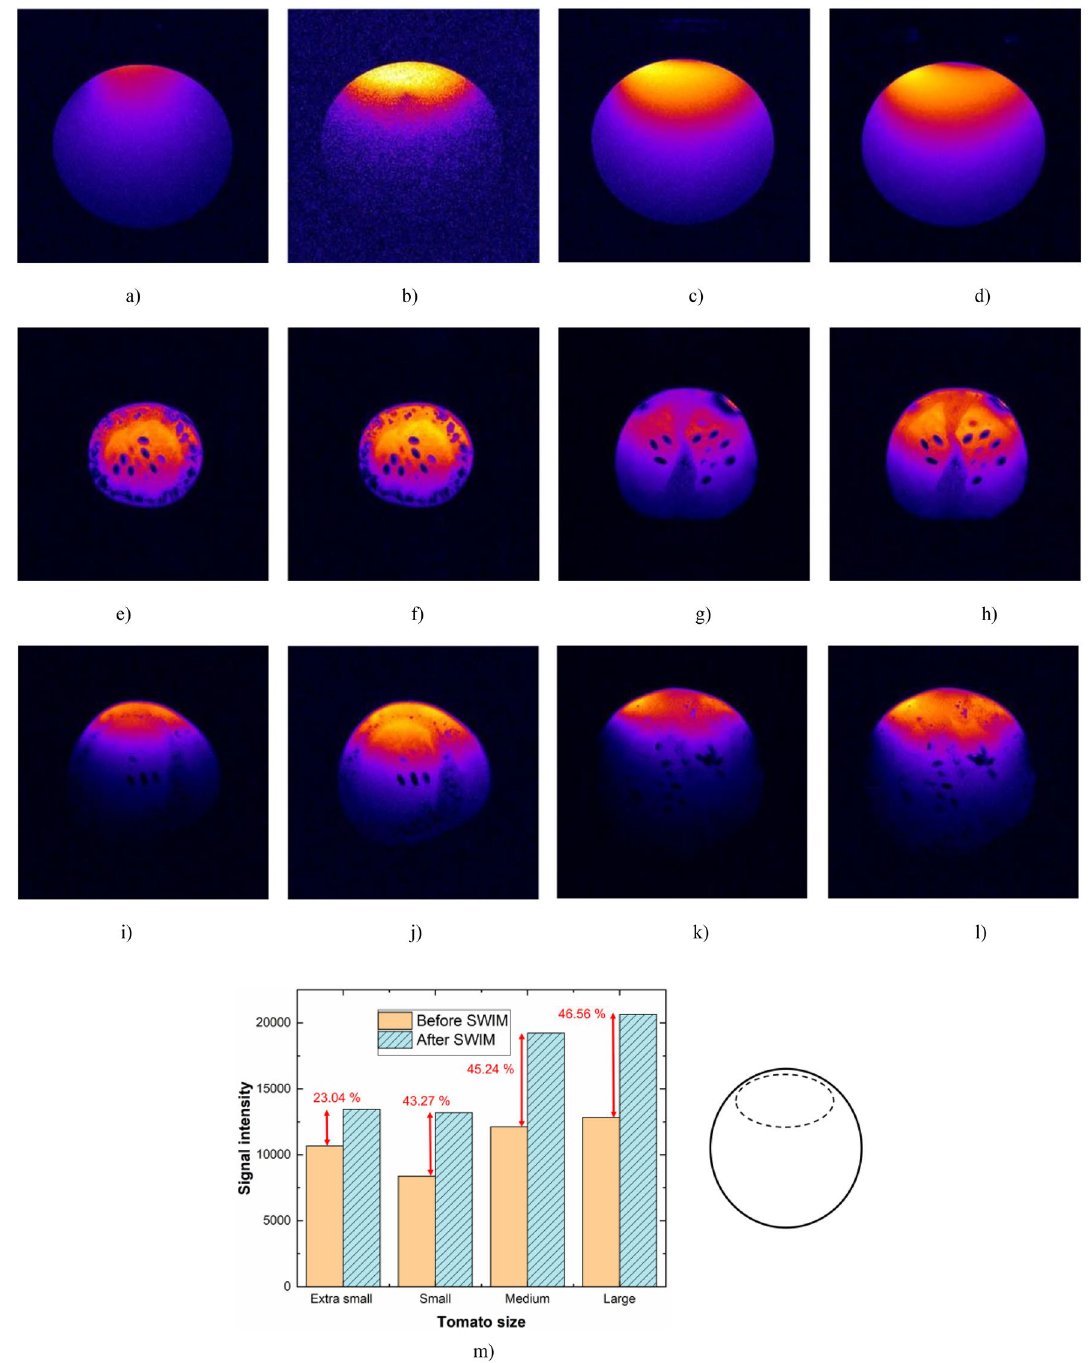
Figure 8. MR images of saline phantom, ( a ) mismatched condition after loading, ( b ) automatic matched condition by the SWIM system with active microcontroller and wireless communication, ( c ) automatic matched condition by the SWIM system with microcontroller in deep-sleep mode, ( d ) manually matched condition without the SWIM system. MR images of various tomatoes before and after SWIM calibration, extra small tomato ( e , f ), small tomato ( g , h ), medium tomato ( i , j ), and large tomato ( k , l ). ( m ) Signal intensity plot of different tomatoes before and after SWIM, calculated from the region closest to the coil as shown